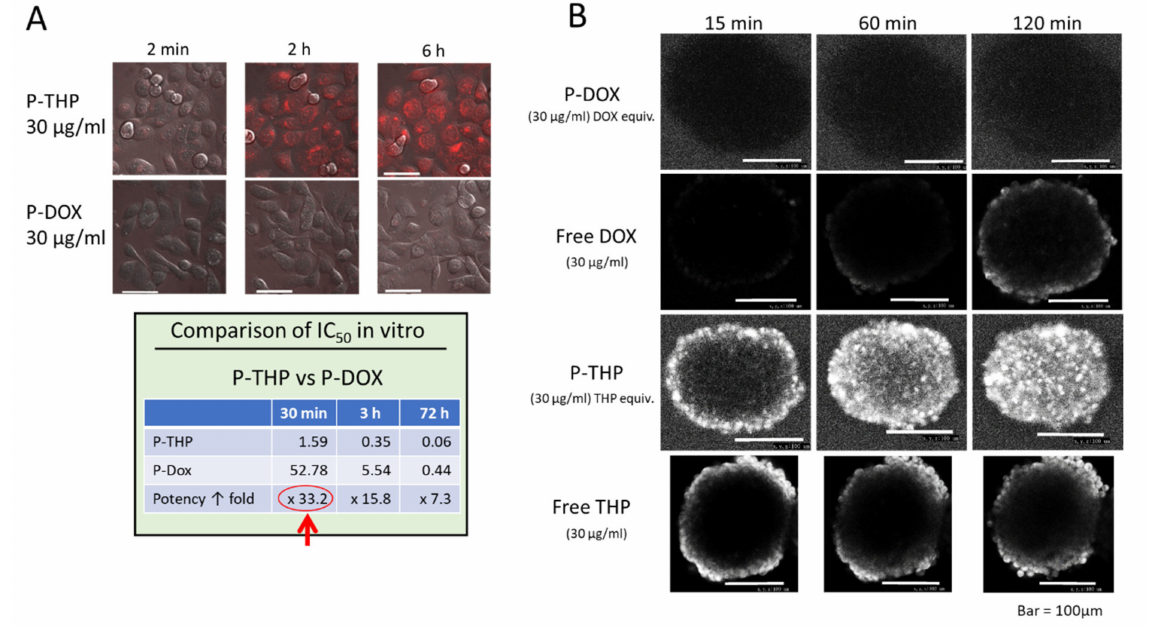
Figure 2. Comparison of the cellular uptake of P-THP—the poly(hydroxypropylmethaacrylamide [HPMA]) conjugate of pirarubicin (THP)—and P-DOX (HPMA polymer-DOX conjugate) by human pancreatic cancer cells (SUIT-2) in vitro. ( A ) Polymeric P-THP shows a far greater uptake by tumor cells compared with P-DOX: at 30 min, P-THP had a 33.2-fold higher uptake, and its cytotoxicity had greatly increased (see Table at lower left). ( B ) Penetration of P-DOX, DOX, P-THP, and THP into spheroidal tumor colon cancer (Adapted with permission from ref. [39,40]. 2016 American Chemical Society, 2019 American Chemical Society). Far greater penetration of P-THP into the tumor spheroid (similar to Figure 2, Table) is